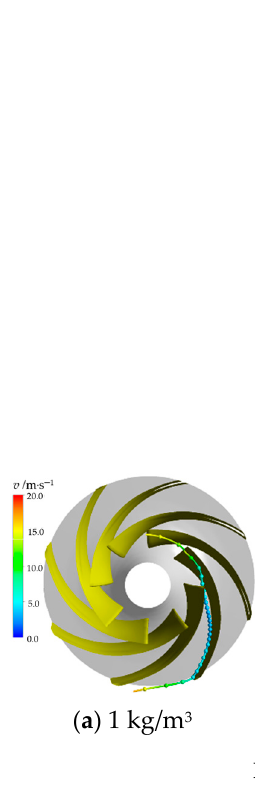
Figure 15. Tangential velocity and erosion rate change with vortex core radius.